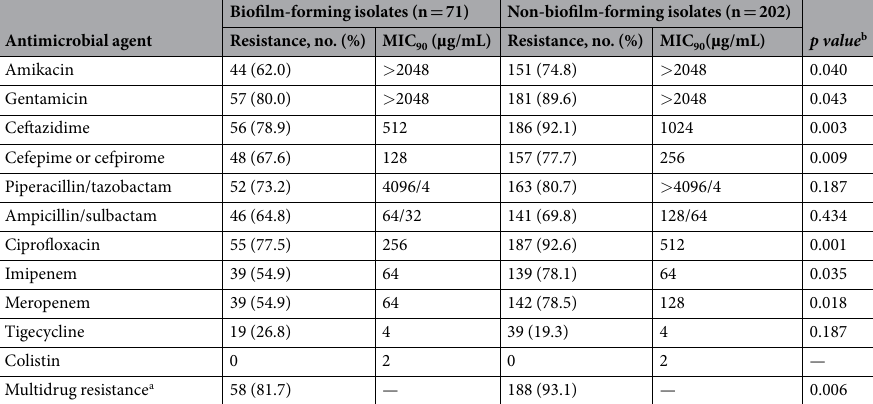
Table 4. Comparison of the antimicrobial susceptibilities of biofilm-forming and non-biofilm-forming Acinetobacter baumannii isolates. a Definition: resistance to three or more of the following classes of antimicrobial agents: anti-pseudomonal cephalosporins, anti-pseudomonal carbapenems, ampicillin/ sulbactam, fluoroquinolones and aminoglycosides. b p value: The difference in resistance rate to antibiotics between biofilm-forming isolates and non-biofilm-forming